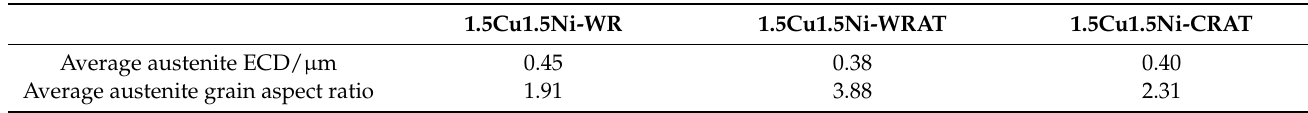
Table 3. Average equivalent circular diameter (ECD) and aspect ratio of austenite grains of 1.5Cu1.5Ni- (WR, WRAT, and CRAT)